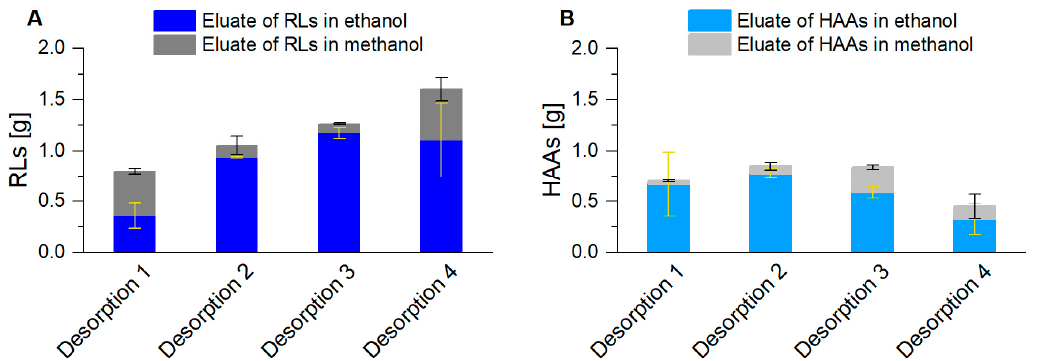
Figure 6. Product harvest (( A ): RLs; ( B ): HAAs) after foam adsorption and subsequent desorption, first with ethanol (blue) and then with methanol (gray) for each elution. Two adsorption columns alternated every 8 h, for 32 h, resulting in 4 desorption procedures. The error bars indicate the deviation from the mean of two biological replicates.